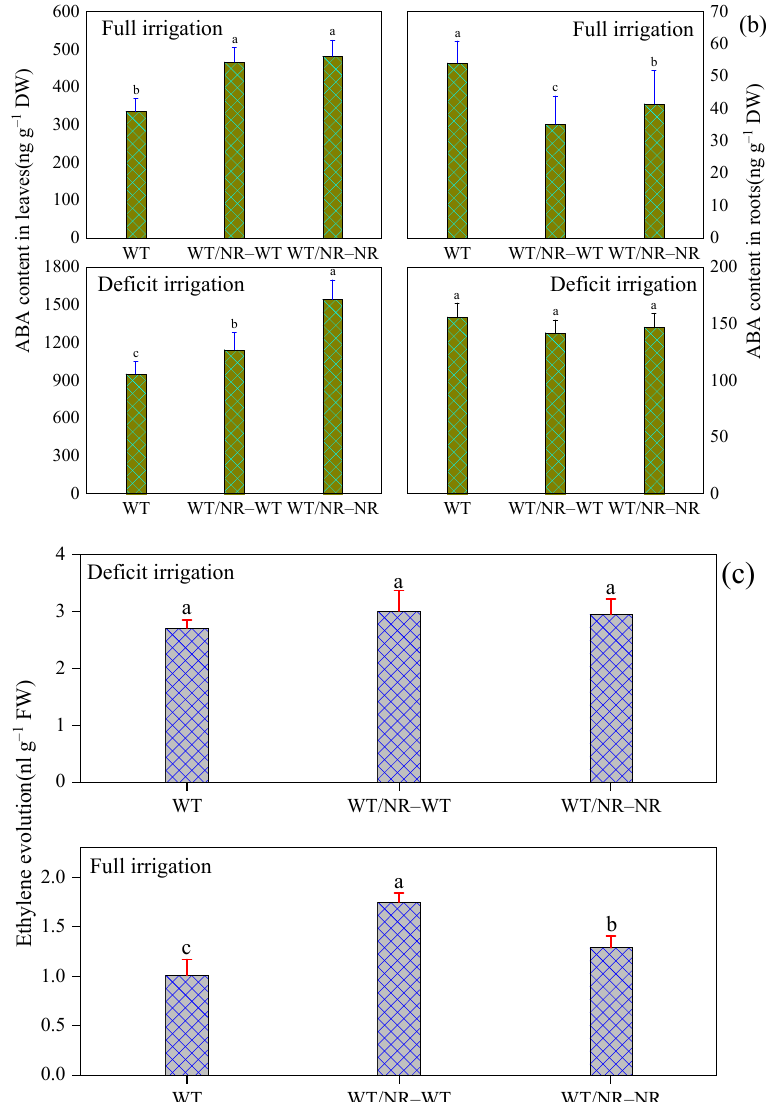
Figure 5. Effects of intraspecific competition on stomatal conductance ( a ), ABA content in leaves and roots ( b ), and ethylene evolution ( c ) of the single WT tomato and the competing plants from pot with WT and NR tomato under full irrigation and deficit irrigation (* p < 0.05, ** p < 0.01). Different letters denote statistically significant differences between treatments ( p < 0.05). n.s. means statistically insignificant difference between treatments ( p >